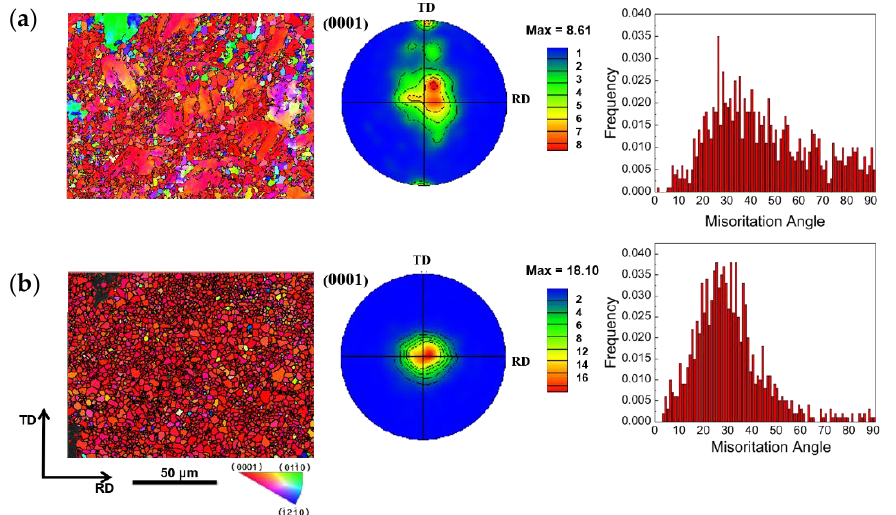
Figure 7. EBSD IPF maps, (0001) PFs, and misorientation-angle distribution of SR: ( a ) SR-8.6 mm, ( b ) SR-3.4 mm.